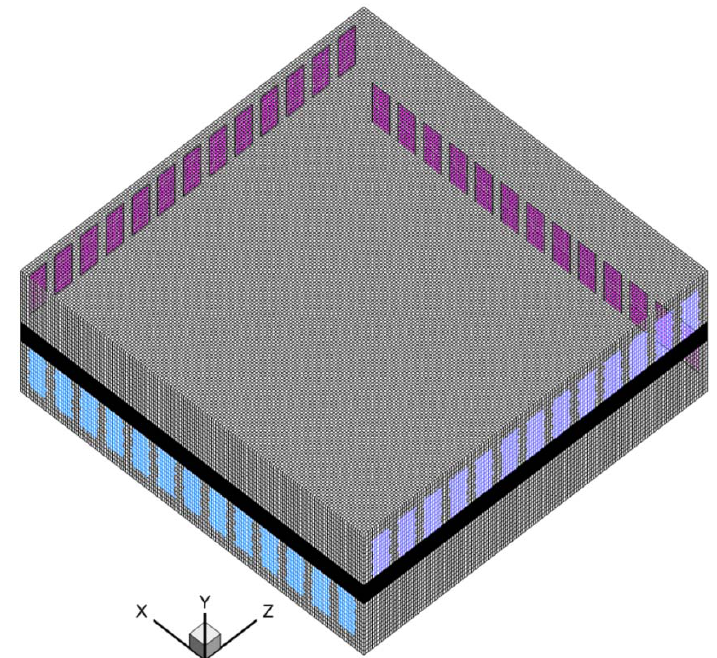
Figure 2. The mesh arrangement for the cross-flow configuration computation domain (not in